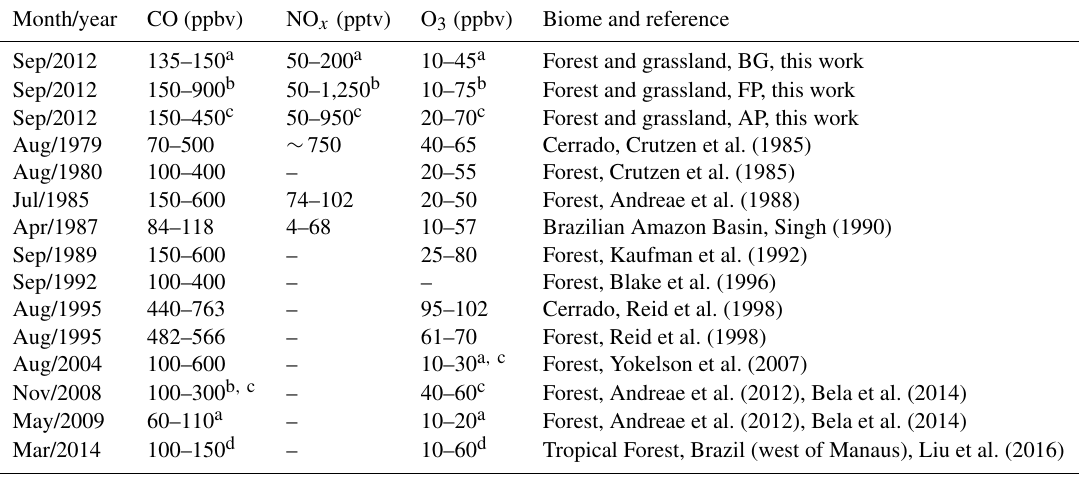
Table 3. Airborne measurements of CO, NO x , and O 3 mixing ratios in Amazonia and cerrado areas in